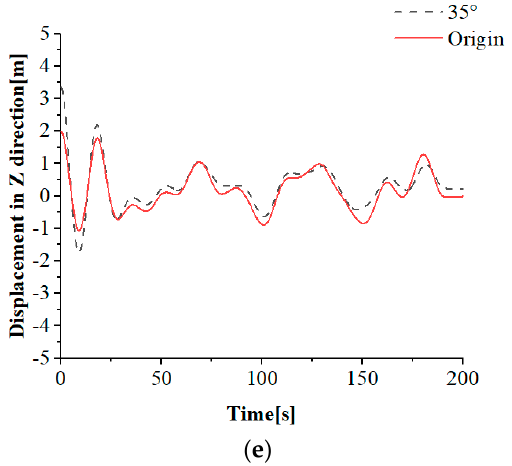
Figure 31. Z direction displacement of the pedestal under different wave heights. ( a ) H = 9 m; ( b ) H = 7.2 m; ( c ) H = 5.4 m; ( d ) H = 3.6 m; ( e ) H = 1.8 m.